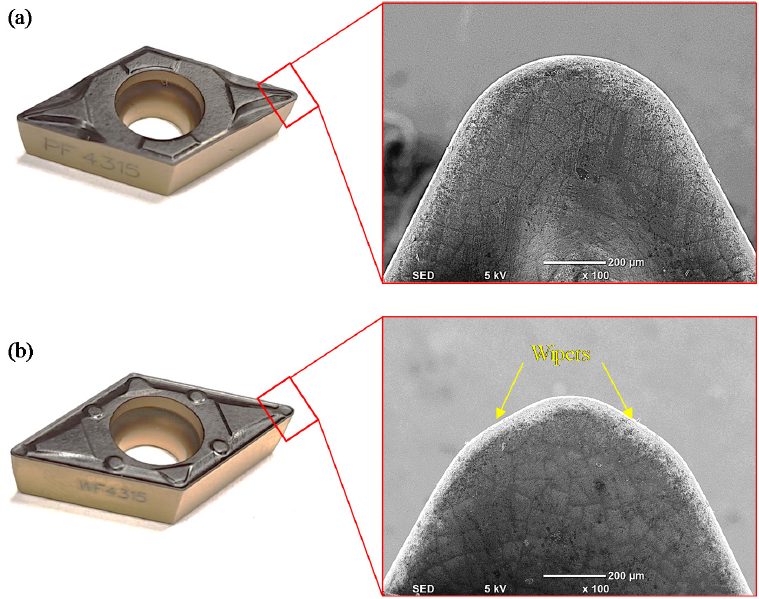
Figure 2. Cutting inserts: ( a ) conventional insert and ( b ) wiper insert.